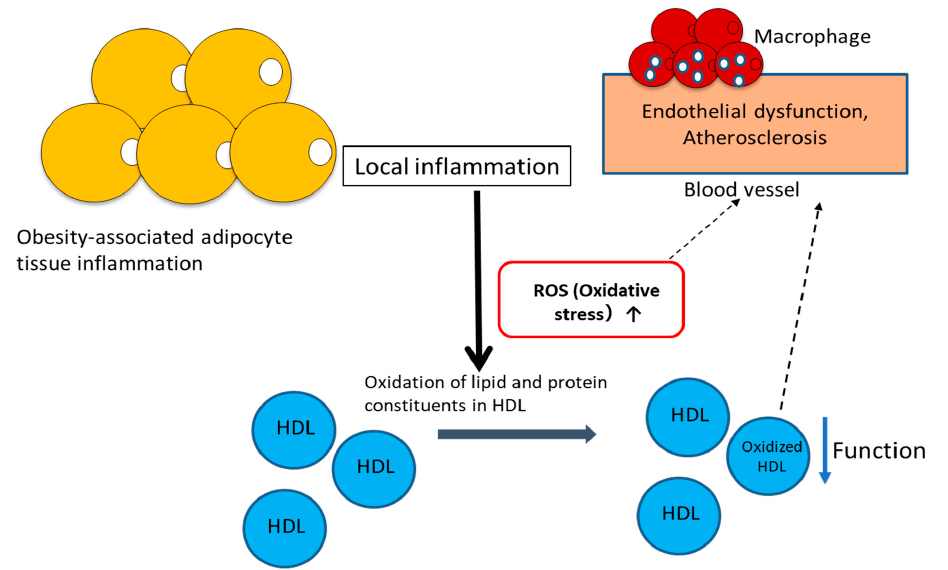
Figure 2. Reactive oxygen species (ROS) and ROS-induced oxidative modification of HDL cause endothelial dysfunction and progression of